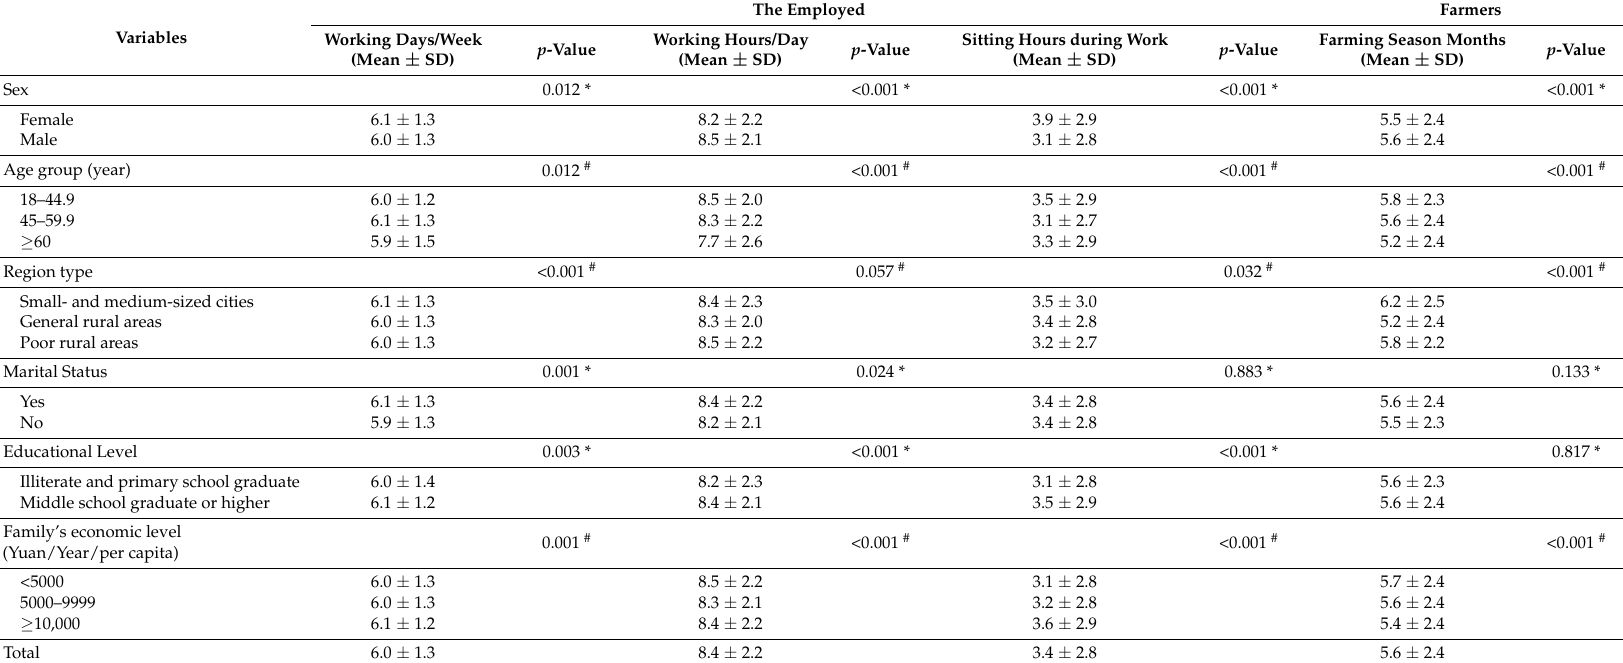
Table 2. Occupational physical activity time of the employed and